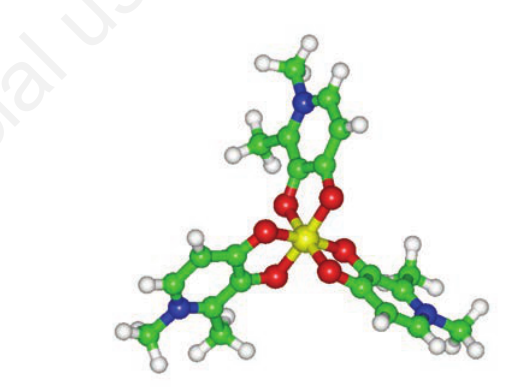
Figure 11. 3:1 iron(III) complex of 1,2-dimethyl-3-hydrox- ypyridin-4-one.